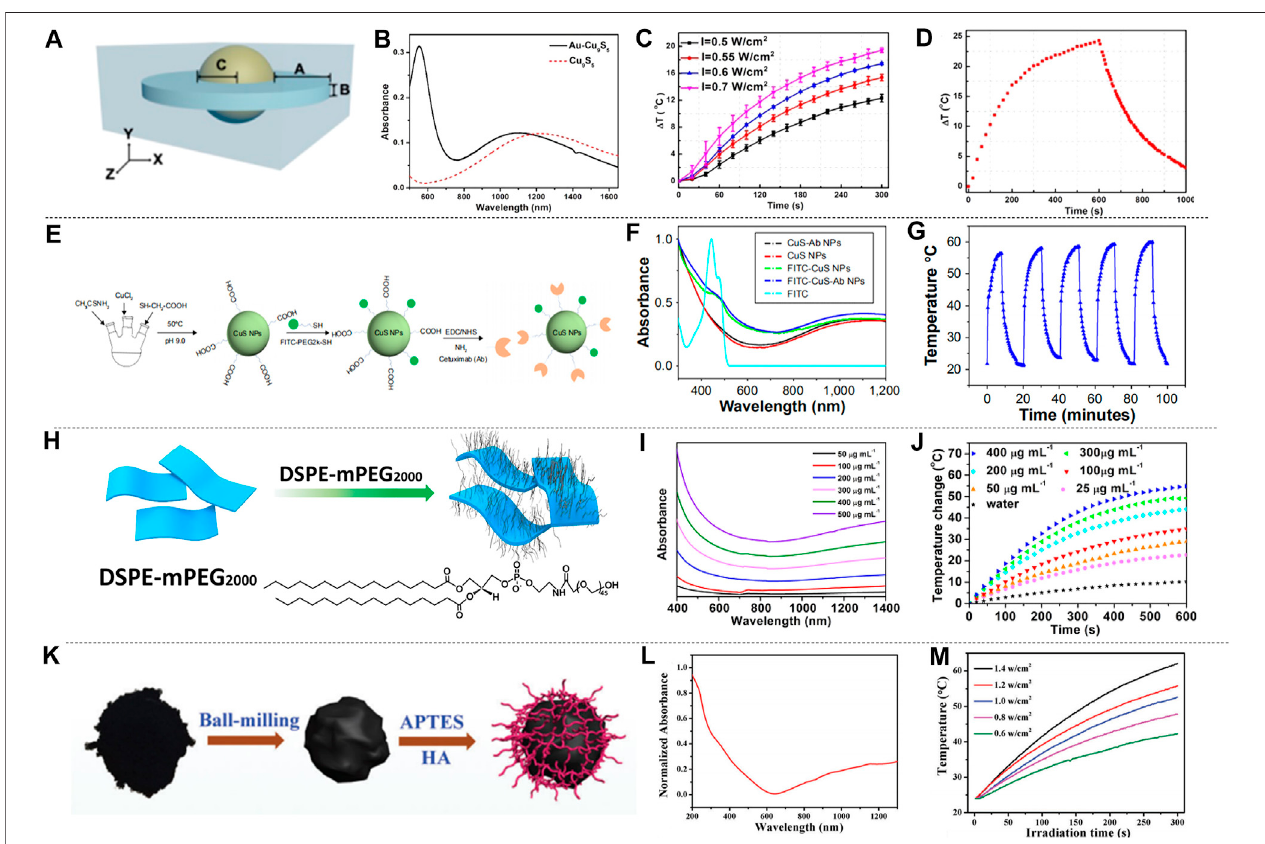
FIGURE5| Photothermalcharacteristicsofmetalsulfuroxides. (A) DDAsimulationstructurediagramofAu-Cu 9 S 5 NPs. (B) TheabsorptionspectrumofAu-Cu 9 S 5 NPs. (C) Temperature characteristiccurvesofAu-Cu 9 S 5 NPssolutionsexcitedby1,064 nm withdifferentpower densities. (D) Temperature changegraphofAu-Cu 9 S 5 NPs solution excited by 1,064 nm laser (reproduced from (Ding et al., 2014) with permission from American Chemical Society). (E) Synthesis of CuS-Ab NPs. (F) Absorption spectrum of CuS-Ab NPs. (G) The temperature change curve of the CuS-Ab NPs solution irradiated by a 1,064 nm laser for fi ve cycles (reproduced from (Li et al., 2018) with permission from Dove Medical Press LTD.). (H) Schematic diagram of DSPE-mPEG wrapped TONW NRs. (I) Absorption spectra of different concentrations of PEG-TONW NRs solutions. (J) The temperature rise curve of PEG-TONW NRs solution with different concentrations irradiated by a 1,064 nm laser (reproducedfrom(Chengetal.,2019)withpermission fromAmericanChemicalSociety). (K) Titaniumdioxidesynthesisdiagram. (L) AbsorptionspectrumofTi 2 O 3 NPs. (M) Temperature-time graphsofTi 2 O 3 NPs irradiated by1,064 nm lasers with different power densities(reproduced from (Zenget al.,2018) with permission from Royal Society of